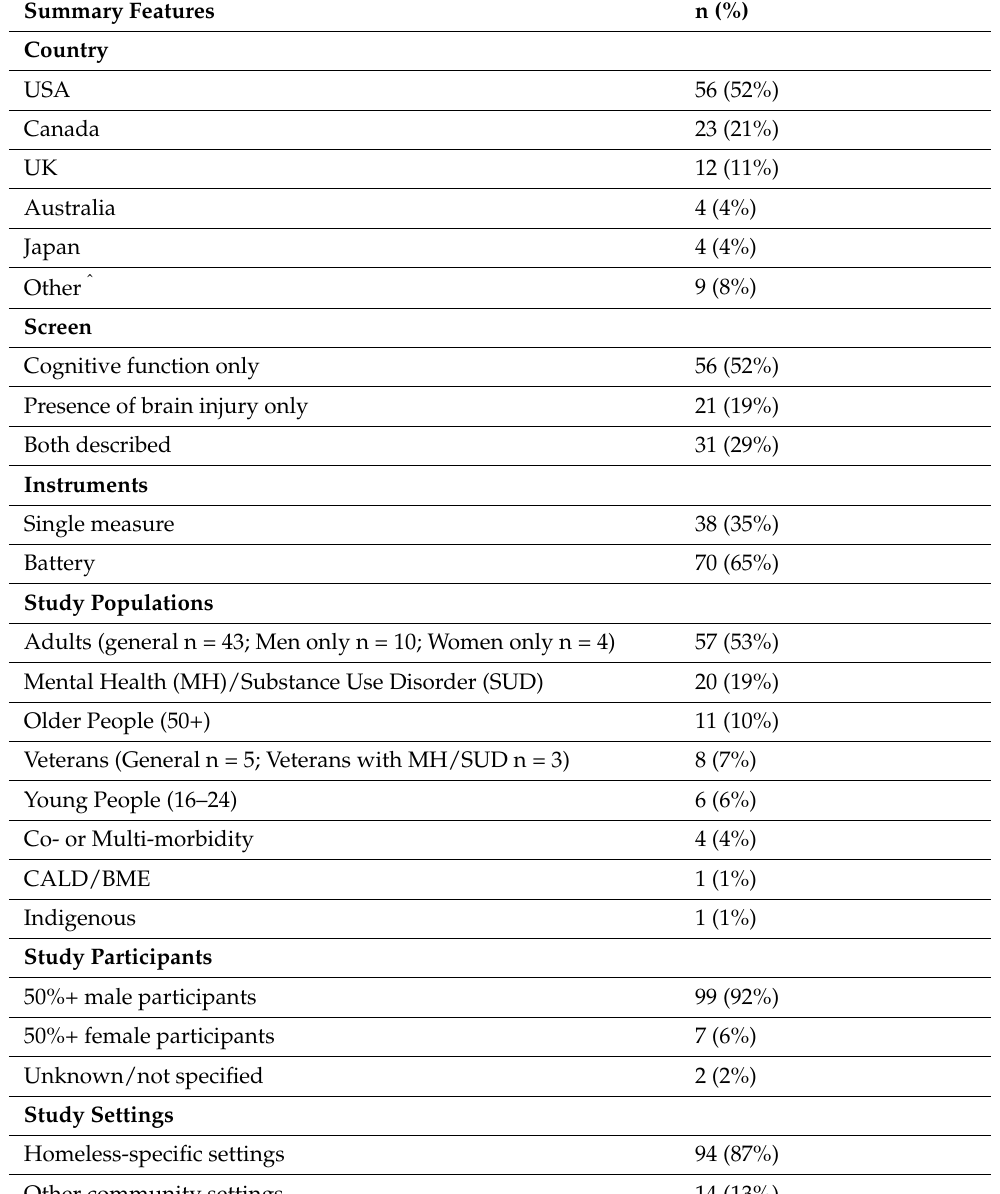
Table 2. Literature Summary